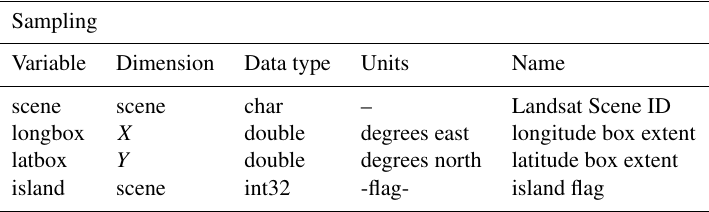
Table A4. These are the data from the polygons, including the Landsat scene ID used to draw the polygons. The island flag is used when islands are visible inside the polygon in the imagery when drawing the mask.